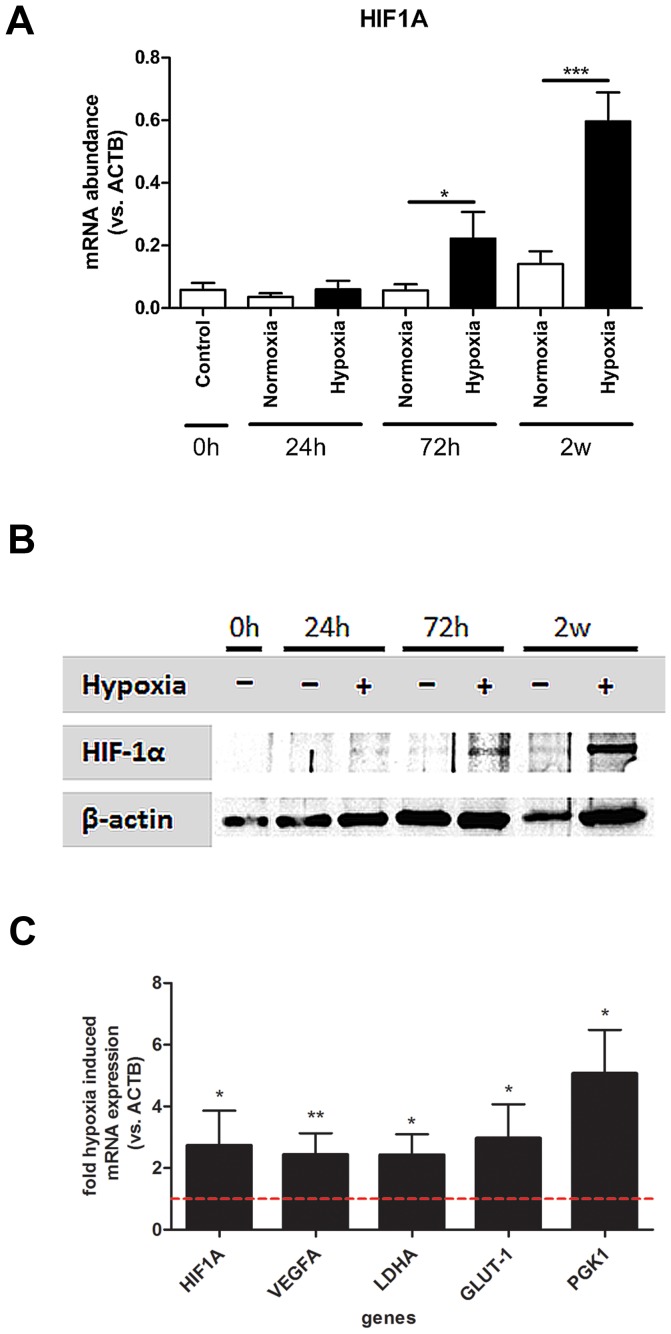
Hypoxia induces HIF-1α and HIF-1-target-gene expression.(a) HIF1A gene expression of human MSCs obtained by real-time PCR (n = 6; unpaired t-test). (b) HIF-1alpha and beta-actin protein expression obtained by immunoblot. (c) Hypoxia-induced HIF-1-target-gene expression of VEGFA, LDHA, GLUT1, and PGK1 (n = 6; 2-weeks data; one sample t-test; dotted-line indicates normalization to gene expression of normoxic cells; *** p<0.001; ** p<0.01; * p<0.05).